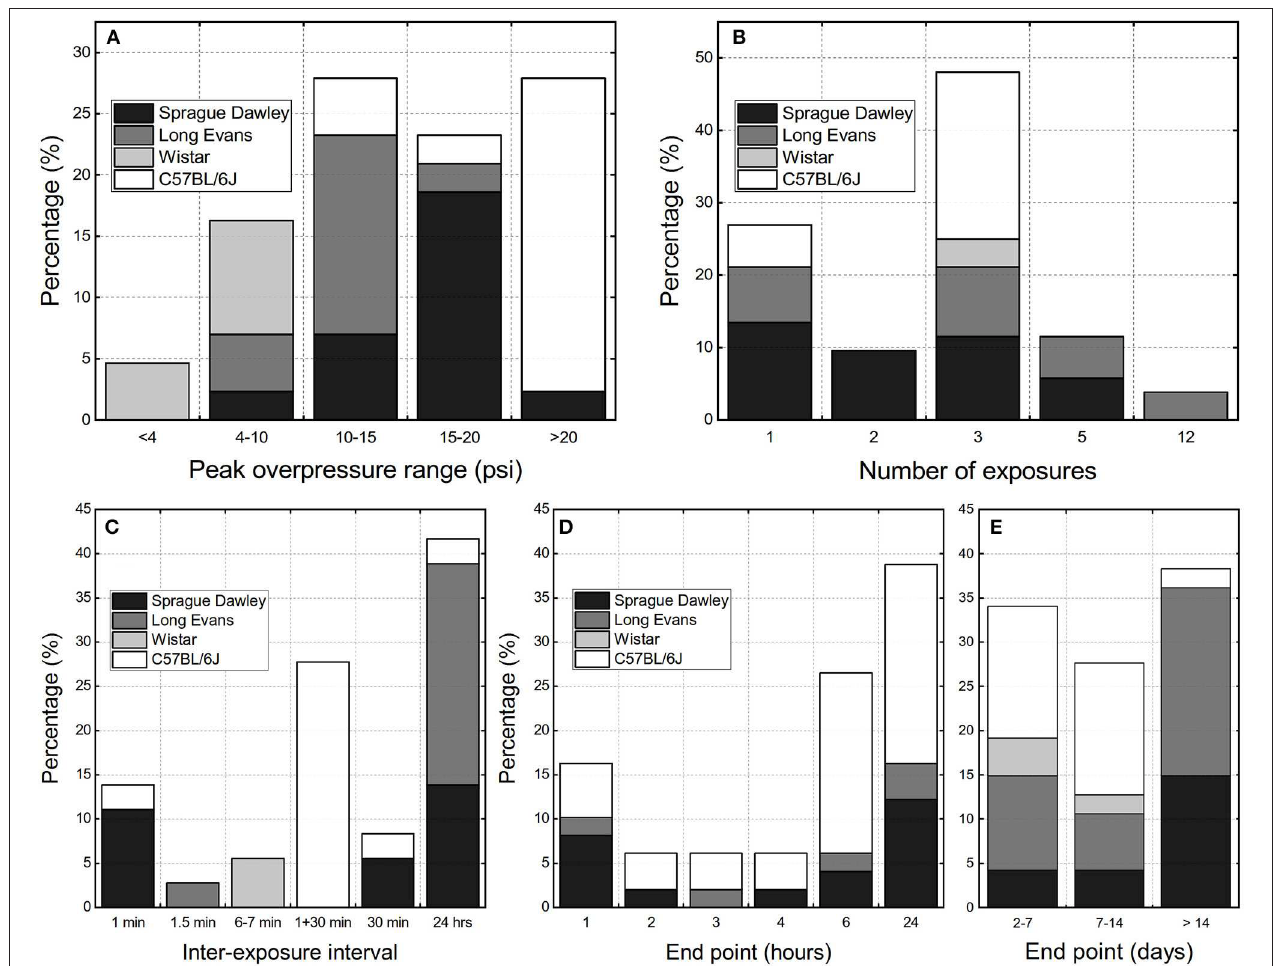
FIGURE 2 | The overview of the experimental design parameters used in the repeated bTBI studies with rodent models expressed as percentage of published peer-reviewed papers: (A) peak overpressure ranges, (B) number of exposures, (C) inter-exposure interval. The terminal endpoints used in the studies: (D) within 24h post-injury, (E) classified as “acute” ( < 7 days), “sub-acute” (7 to 14 days), and “chronic” ( > 14